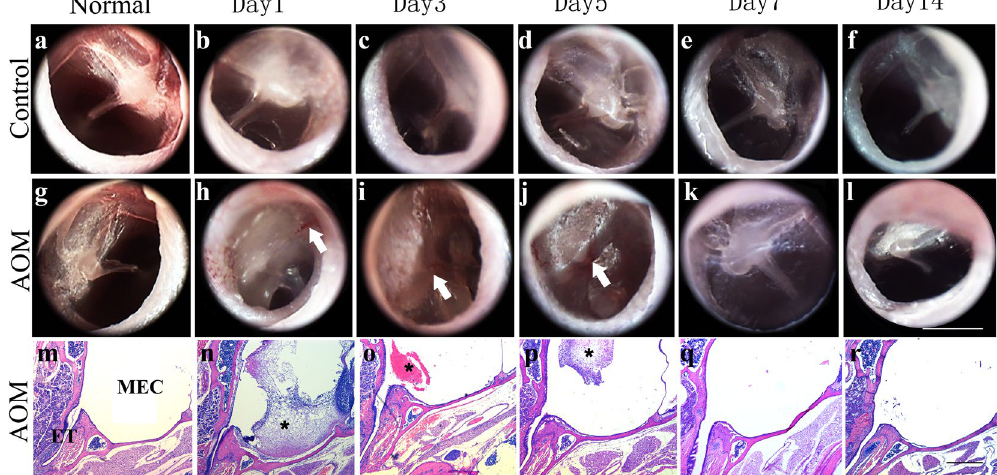
Figure 1. Morphological changes of the tympanic membrane and inflammatory cell infiltration in mouse AOM. Visualization of the tympanic membrane was performed on normal animal and days 1, 2, 3, 7, and 14 post-injection, and photographs were taken at the time of sacrifice under a rigid 4-mm diameter, 0°-angled endoscope. ( a–f ) Tympanic membranes in PBS injected ears as the control group. ( b ) Tympanic membrane thickening was only seen on day 1.Then returned to transparency more quickly and the perforation had healed by days 3–5 ( c , d ). With no congestion or oedema seen in control group. ( g–l ) Tympanic membranes in Streptococcus pneumoniae (10 9 cfu/ml, 5 μ l) injected ears. ( h ) Tympanic membranes started thickening on day 1. The changes in the tympanic membranes peaked at days 3 and 5 ( i , j ). White arrows showed expanded blood vessels. ( k) All of the pathologic changes began to return to normal starting from day 7. ( l) On day 14, the membranes were back to normal; in some of them, scars and small calcifications were visible. ( m – r) H&E staining of the bullaes after Streptococcus pneumoniae caused mouse AOM. Inflammatory cells were observed to have accumulated in the middle ear cavity on days 1, 3, and 5 ( n , o , p ), particularly on day 1. Asterisks show the infiltrated cells. ET, Eustachian tube; MEC, middle ear